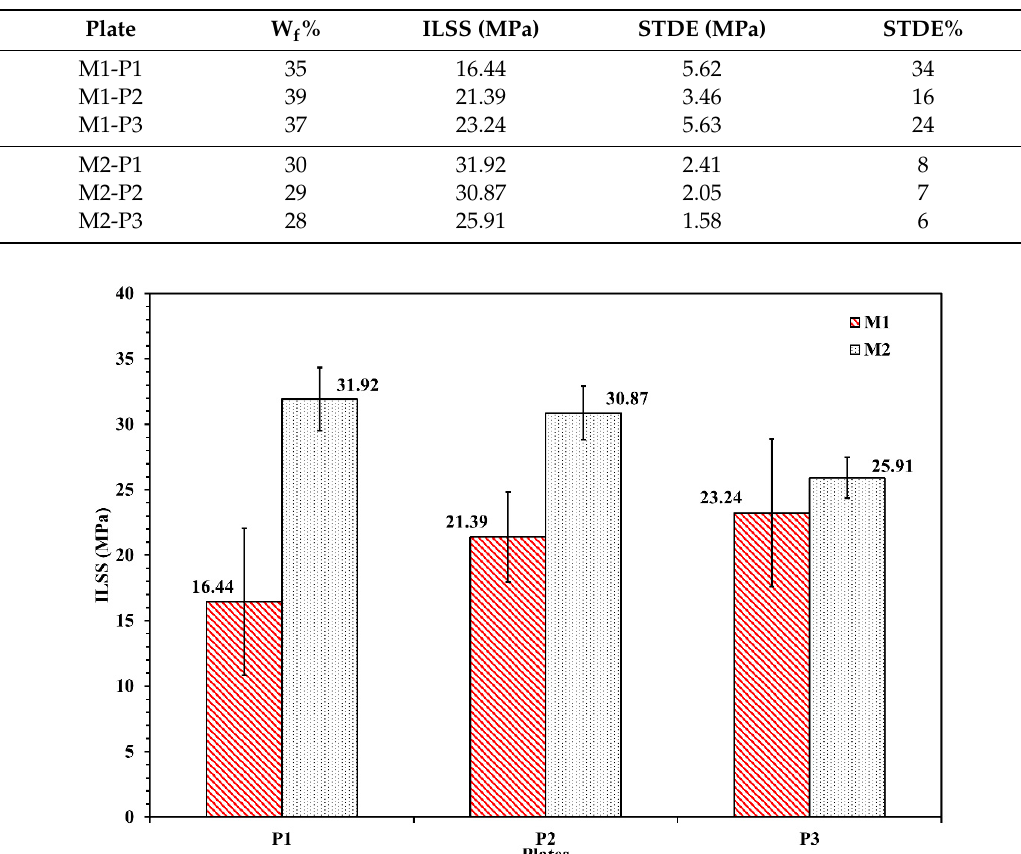
Figure 14. Average ILSS of each plate from both samples sets fabricated by Method 1 and Method 2; despite the superiority of fiber weight fraction in Method 1 plates, it is clear that Method 2 plates are outperforming Method 1 plates by values of 10%, to 90% with higher consistency in standard deviation.